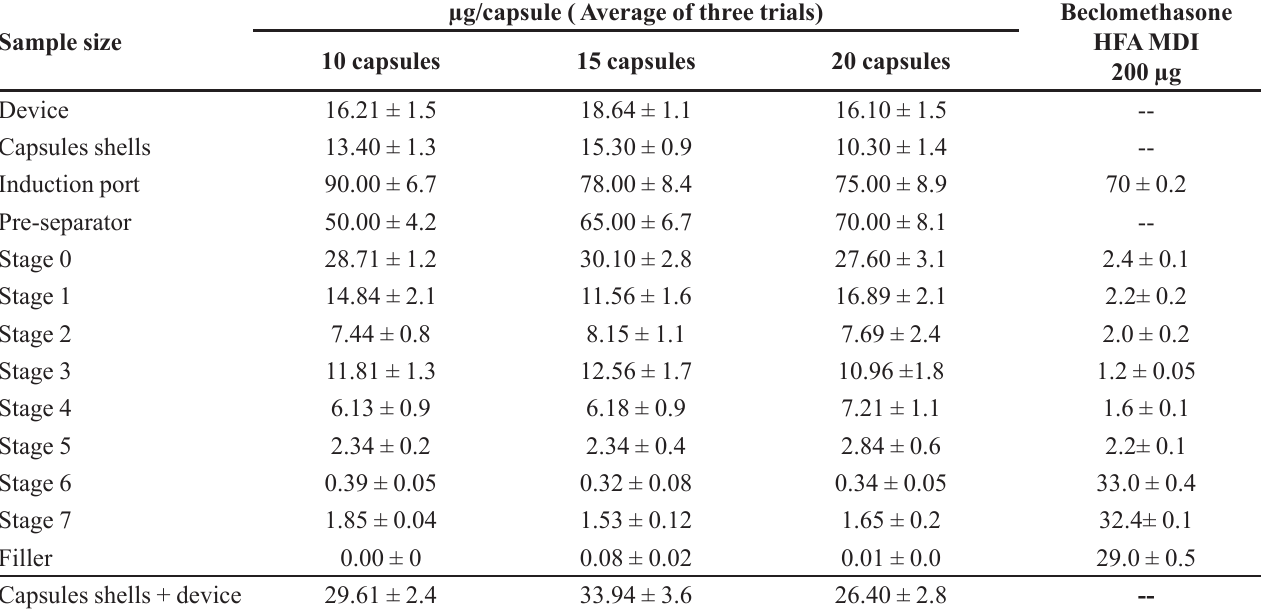
TABLE V - Anderson cascade distribution with various sampling sizes of beclomethasone dipropionate DPI 200 m g and beclometasone MDI 200 m g